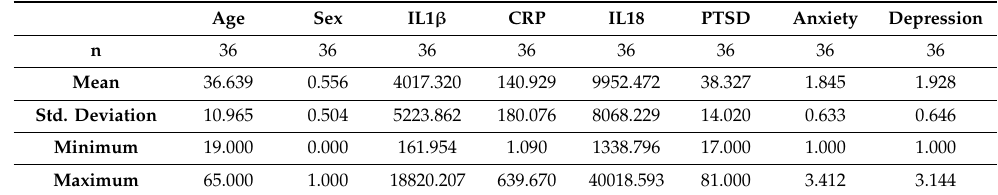
Table 1. Descriptive statistics for sample. Units for inflammatory variables are pg / mL. Values for PTSD, anxiety, and depression denote total severity scores on self-report psychological questionnaires. Mean severity scores for anxiety and depression were above the probable diagnostic threshold of 1.75 each; mean severity score for PTSD was below the probable diagnostic threshold of